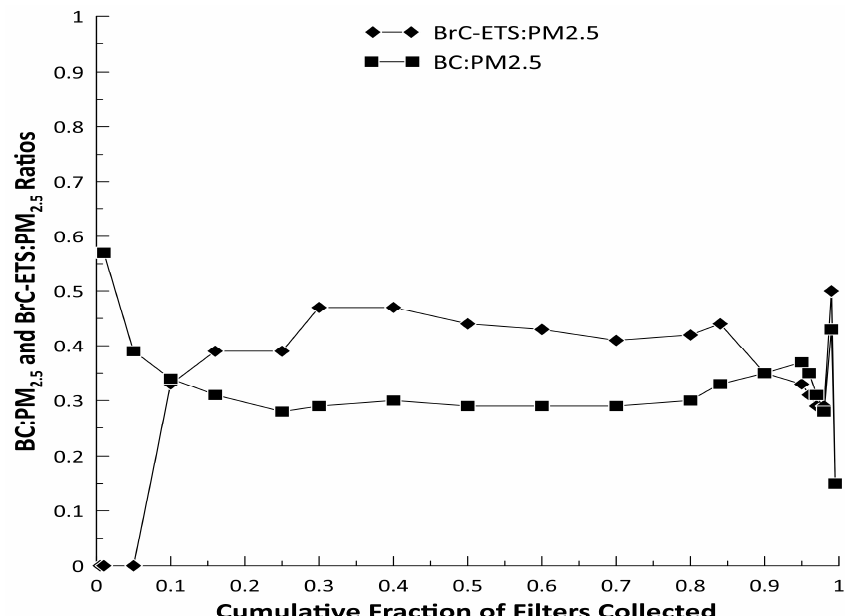
Figure 3. Cumulative distribution of the BrC-ETS:PM 2.5 and BC: PM 2.5 mass ratios measured on the 242 valid filter samples. Cumulative fraction calculation based on the PM 2.5 mass concentration.